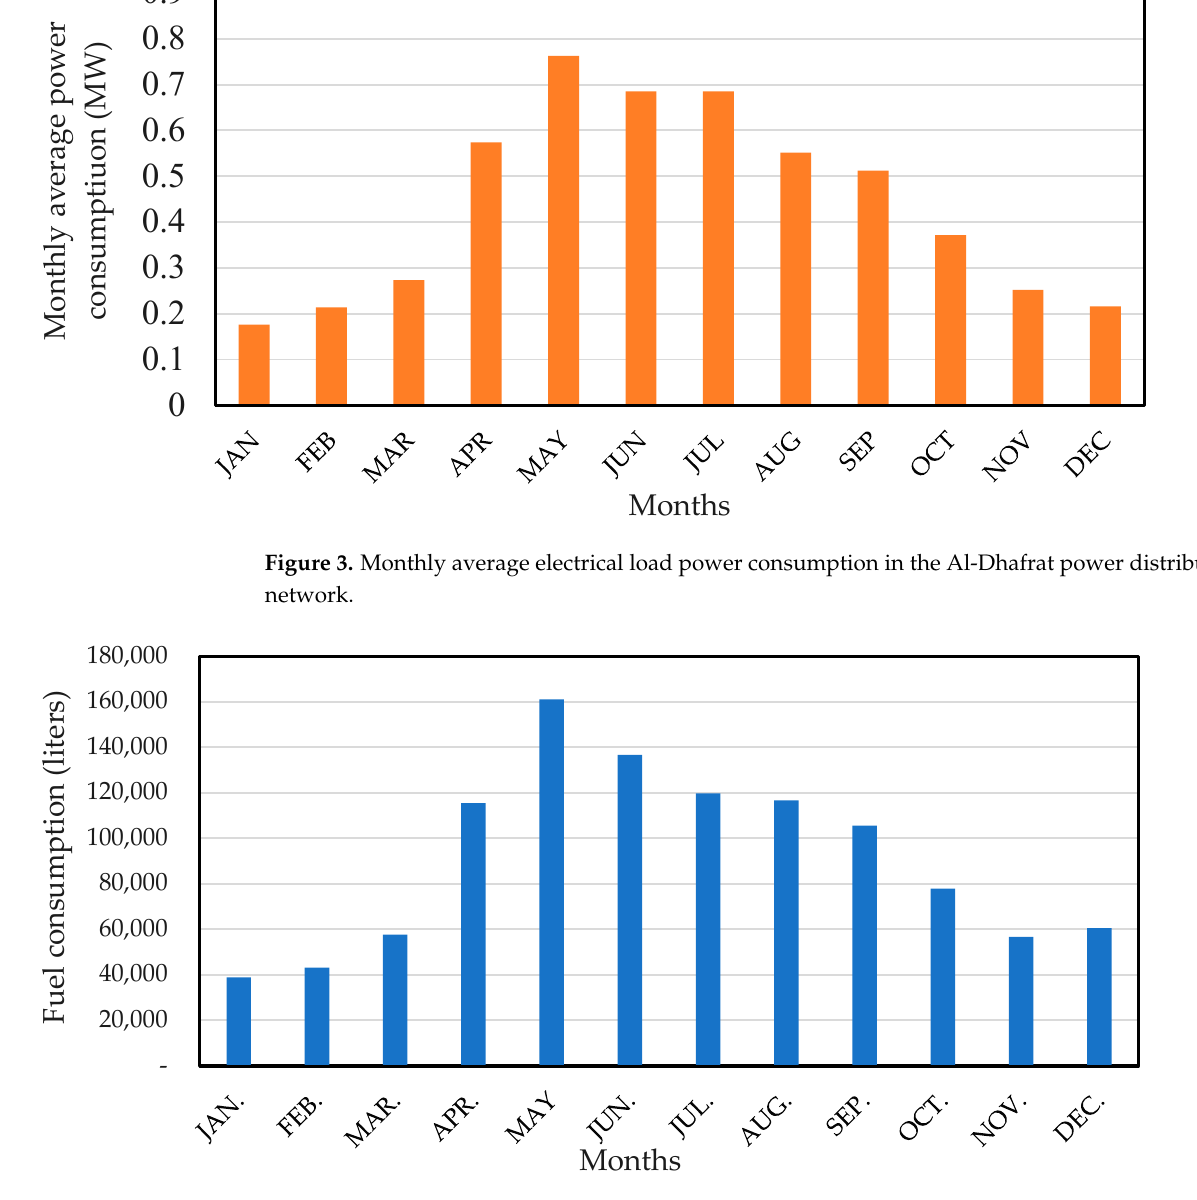
Figure 4. Diesel fuel consumption by the Al-Dhafrat power station.